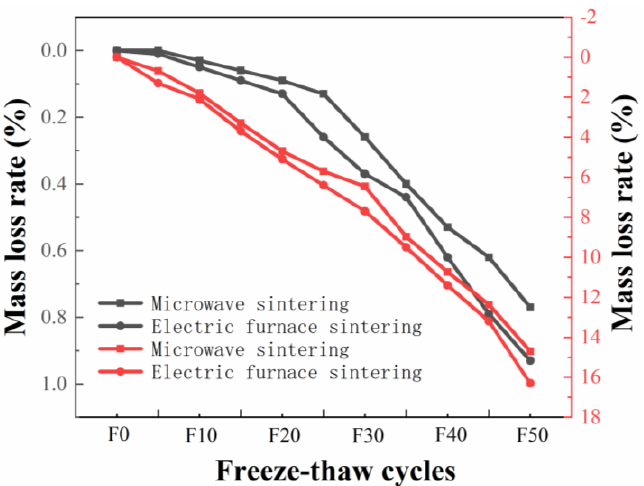
Figure 17. Quality and strength loss rate of recycled brick between two sintering